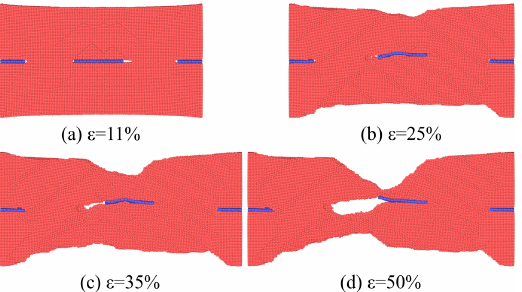
Figure 11. Atomic configuration diagram of Gr/Cu-1 under different strains during stretching. ( a ) ε = 11%, ( b ) ε = 25%, ( c ) ε = 35% and ( d ) ε = 50%.